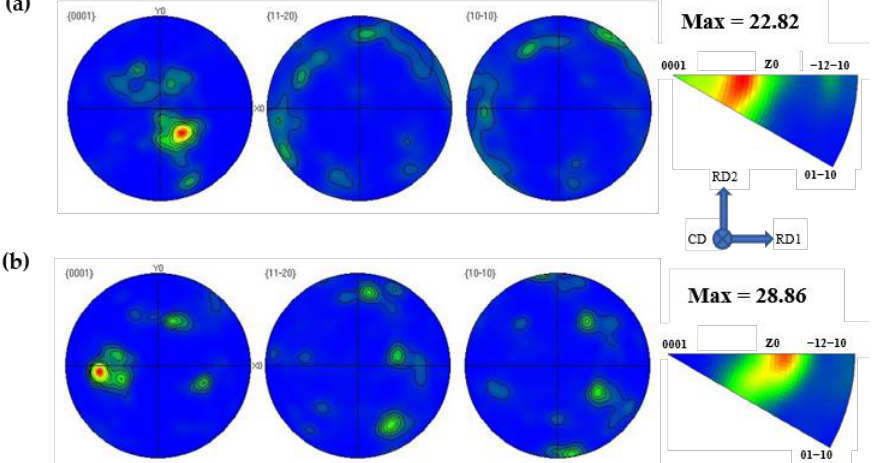
Figure 14. The α -Mg phase pole figure and IPF of the Mg-6Li alloy at the strain rate 0.01 s − 1 ( a ) 473 K, ( b ) 573